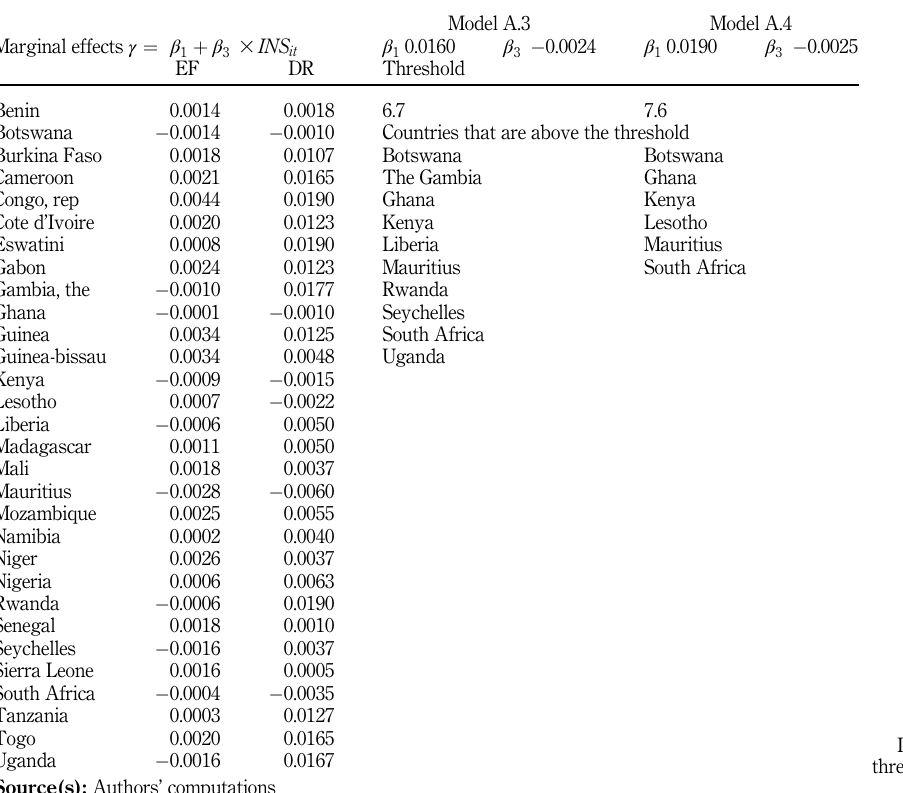
Table 5. Institutional